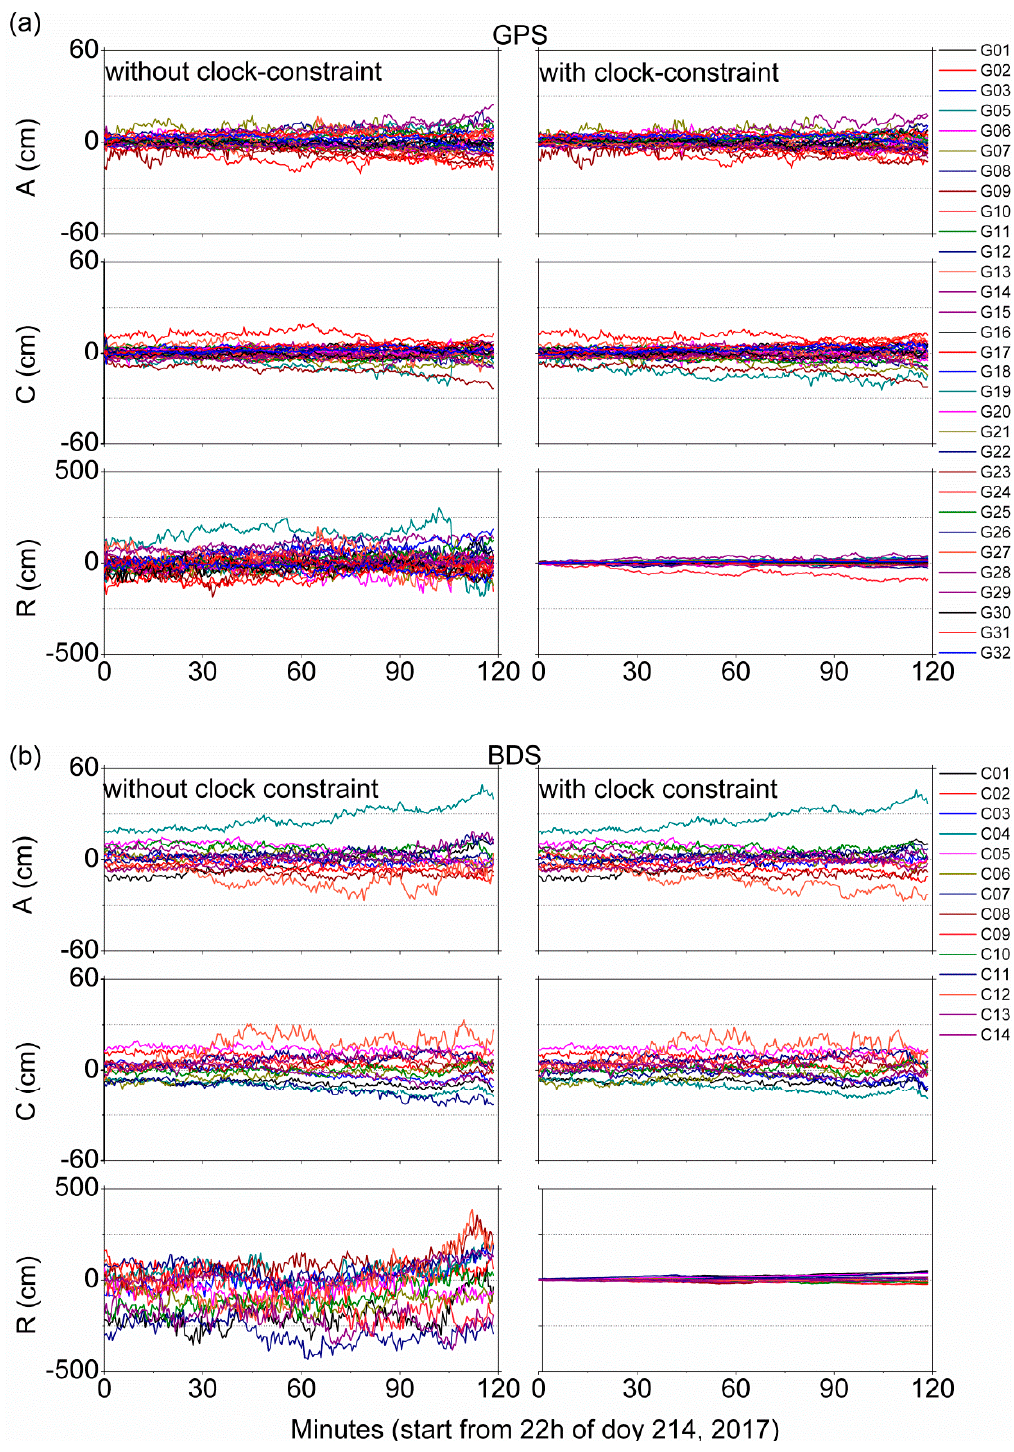
Figure 5. Orbit di ff erences between the RPPP and dynamic POD solutions for GPS and BDS satellites Figure 5. Orbit differences between the RPPP and dynamic POD solutions for GPS and BDS satellites (( a ): Orbit di ff erences for GPS satellites; ( b ): Orbit di ff erences for BDS satellites; left : RPPP without (( a ): Orbit differences for GPS satellites; ( b ): Orbit differences for BDS satellites; left : RPPP without clock-constraint, right : RPPP with clock-constraint, right : RPPP with clock-constraint).